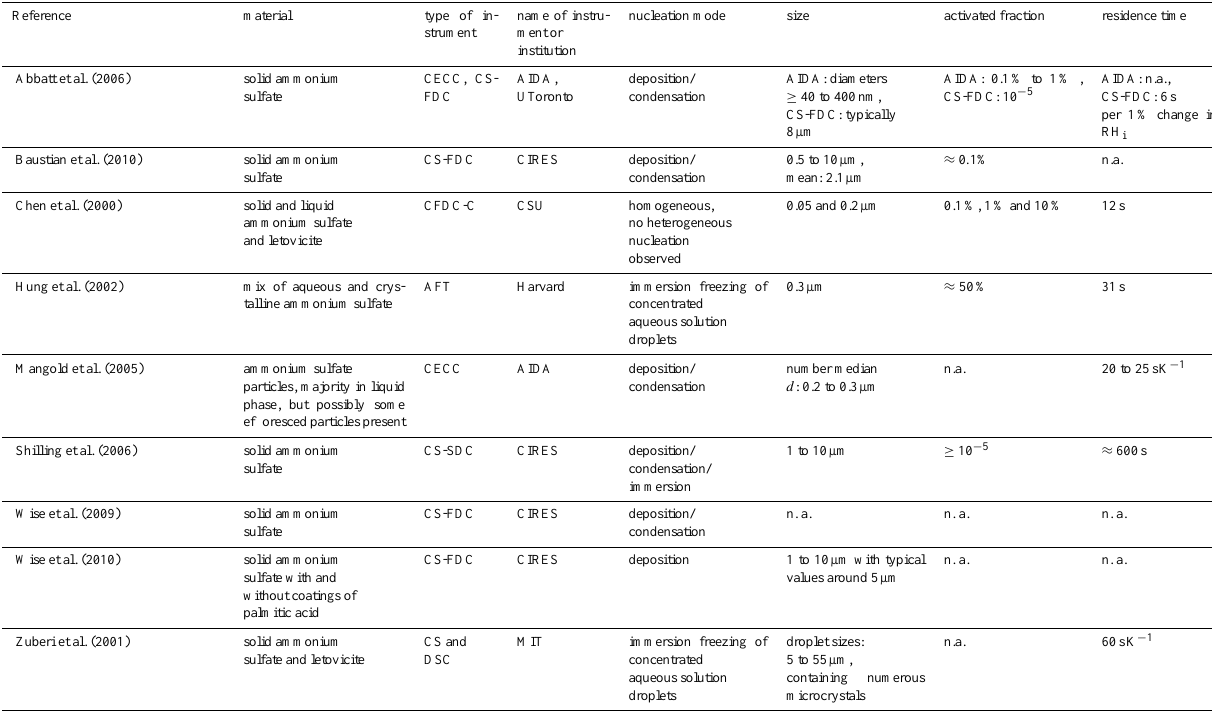
Table 4. Laboratory experiments with solid ammonium sulfate